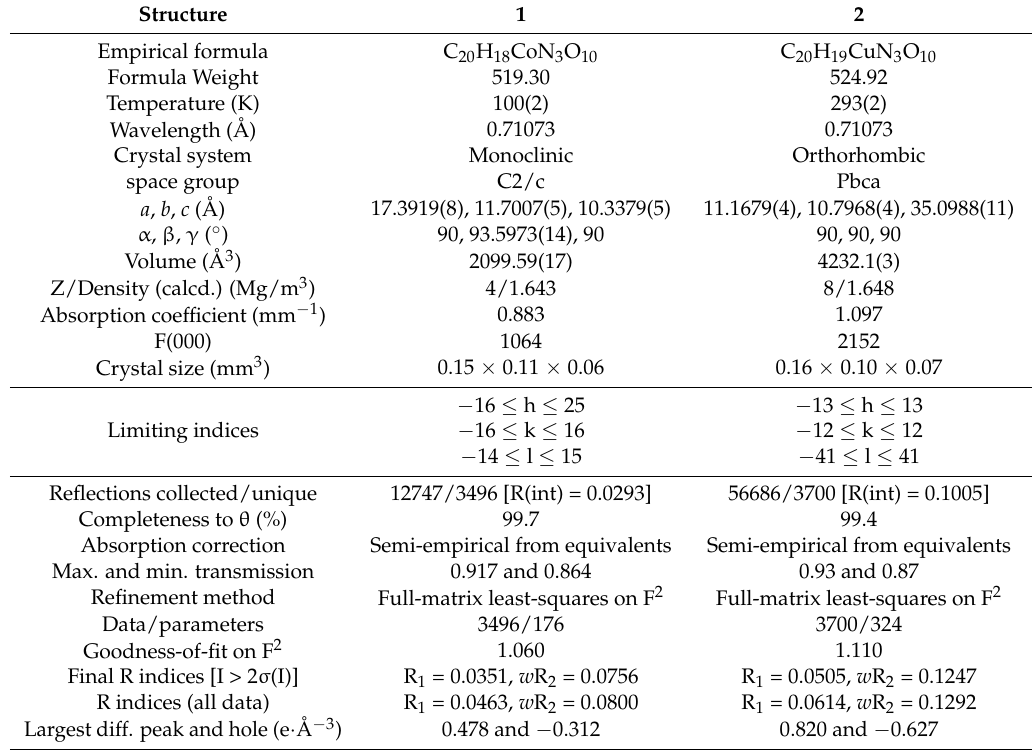
Table 1. CCDC 1816232-1816233 contain the supplementary crystallographic data for this paper. Table 1. Crystal data and structure refinement parameters for 1 and 2